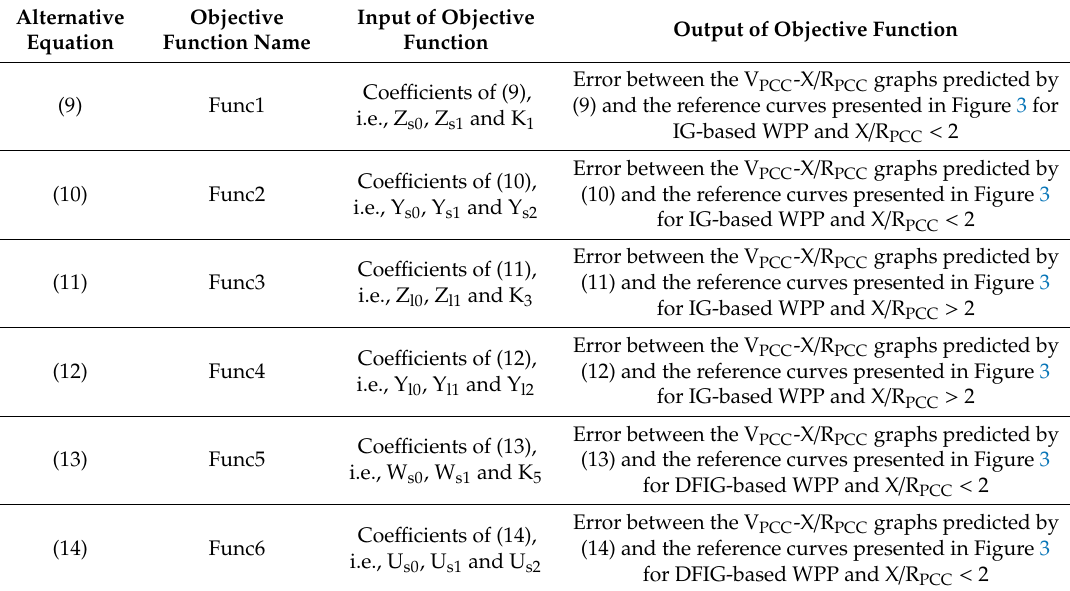
Table 4. Characteristics of the objective